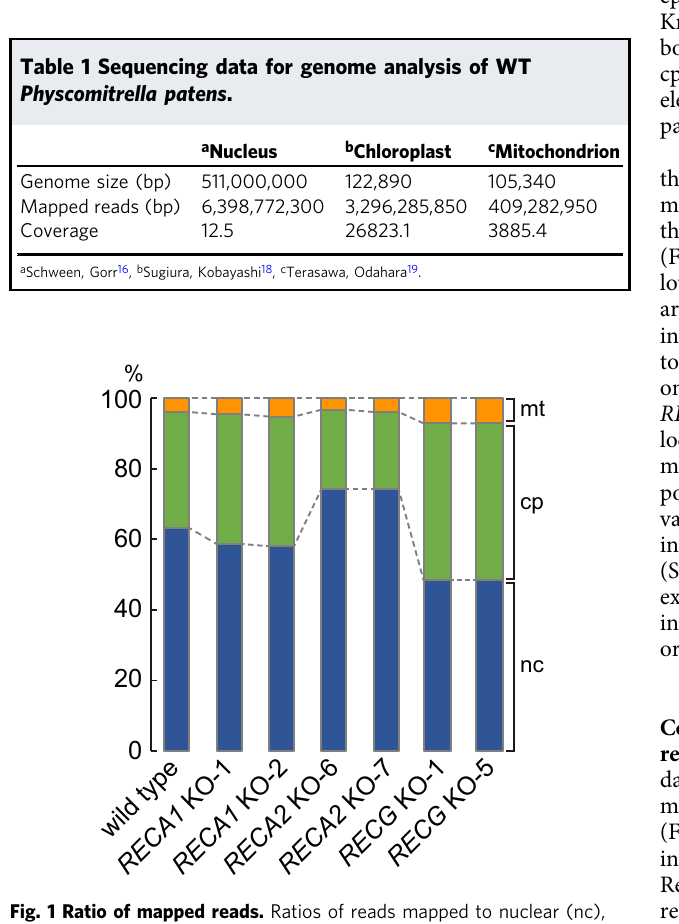
Fig. 1 Ratio of mapped reads. Ratios of reads mapped to nuclear (nc), chloroplast (cp), or mitochondrial (mt) DNA by allowing 75 maximum mismatches in a 150-bp read (h75r10, the mapping parameters of NGS analysis explained in Fig. 4) are shown as percentages of total reads. The source data for the graphs are found in Supplementary Data